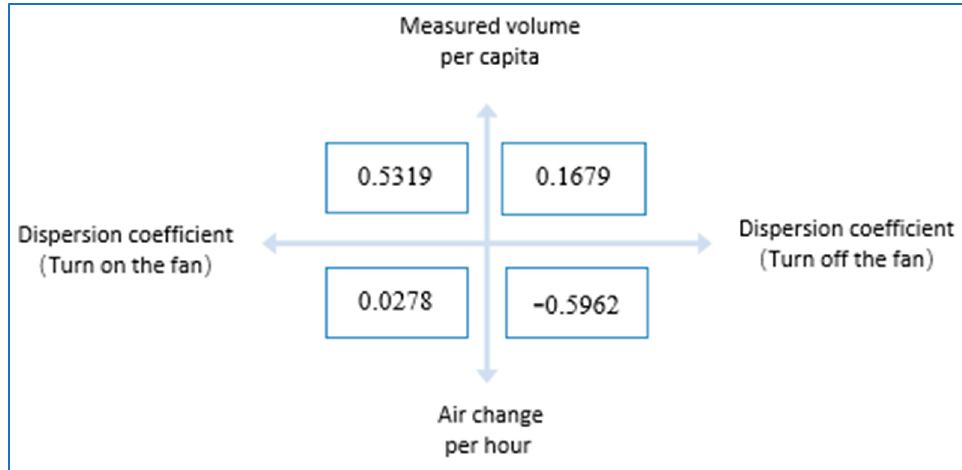
Figure 5. Correlation analysis results.